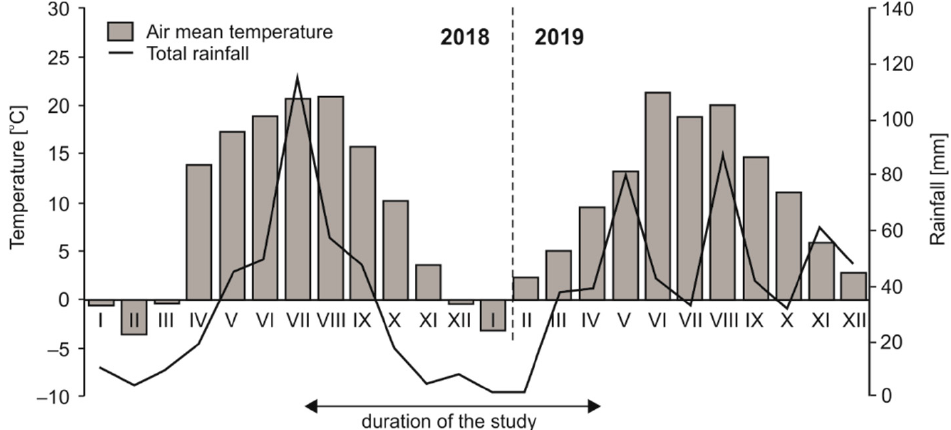
ature in the study area was 8.5 °C and the total annual rainfall was 330 mm. In the studied region, the highest mean temperature reached 20.7 °C in summer, while the lowest value ( − 0.4 °C) was recorded in winter. Based on the regional long-term data (2013–2018), the mean air temperature was 8.5 °C and mean total precipitation was 556 mm. Data for indi- vidual months are shown in Figure 1. The average temperature of the soils in situ were: